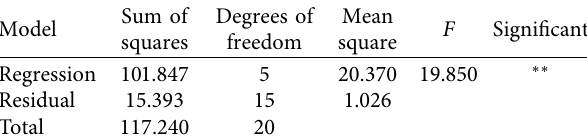
Table 7: Table of variance